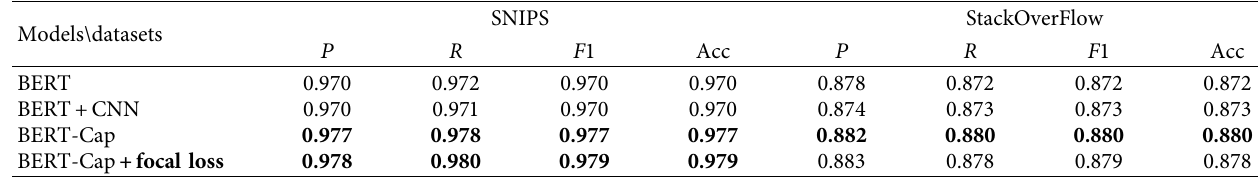
Table 3: The performance of different methods on two English datasets.